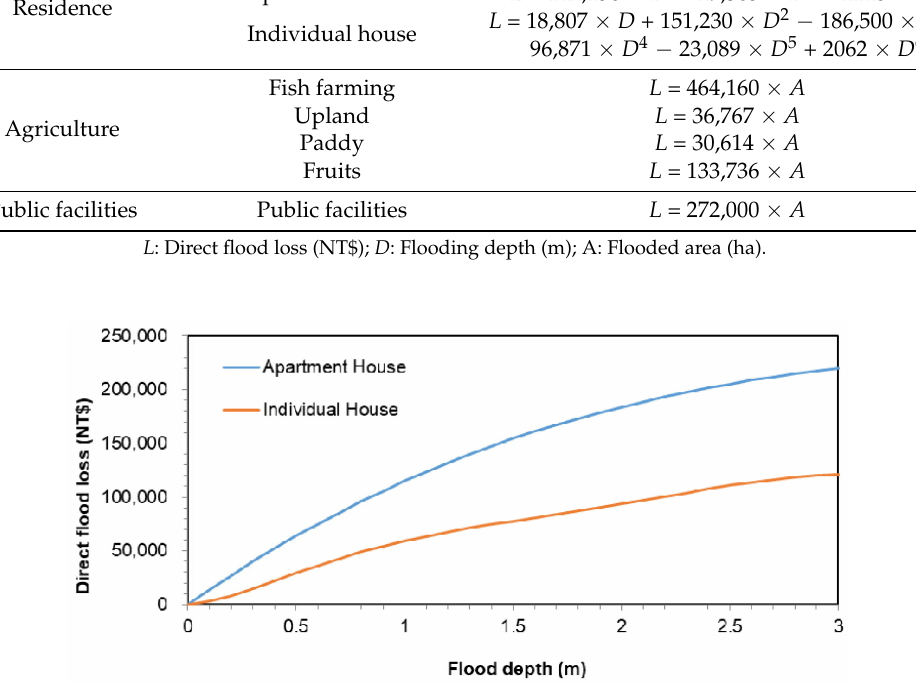
Figure 3. Direct loss curves of flooding for residential sector for Tainan